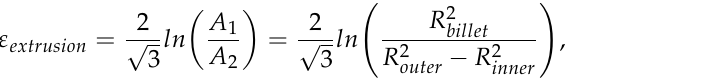
where N is the number of ECAP passes,  and  are the outer and inner angle of ECAP channel, respectively; in our case,  = 90°and, for simplification,  = 0°. The equivalent strain from one ECAP pass in this case then can be estimated as 1.15. However, during the passage of the material through the ECAP part, there were not only radial but also cir- cumferential strains which lead to an additional strain increment, which modifying Equa- tion (2): ), (3) 𝑅 𝑜𝑢𝑡𝑒𝑟22 − 𝑅 𝑖𝑛𝑛𝑒𝑟22 and results in an equivalent strain of 1.13 ( R outer 1 = 5.5 mm, R inner 1 = 3.5 mm, R outer 2 = 13 mm, R inner 2 = 11 mm). Thus, the total equivalent strain from the translational movement of the material through the CSET is 4.03. The simultaneous rotation of the mandrel leads to shear deformation due to the fric- tion between the mandrel and the sample surface. The effect of the friction has to be eval- uated with regard to the mutual directions of the sample mandrel surface orientation and translational movement of the material. The vertical part of the mandrel tip introduces a